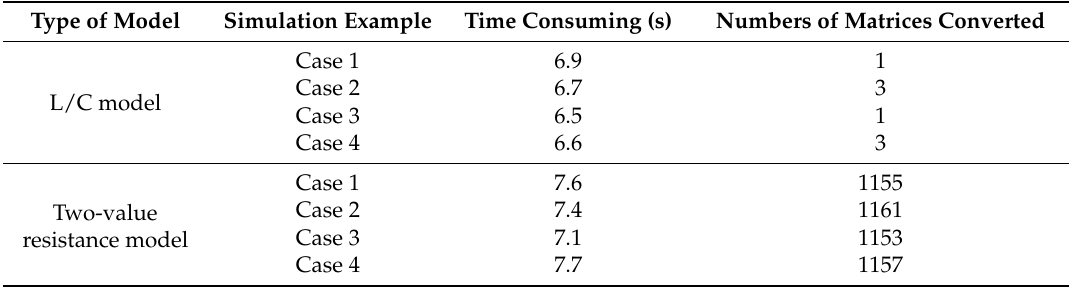
Table 5. Time consuming and numbers of matrices converted of the two